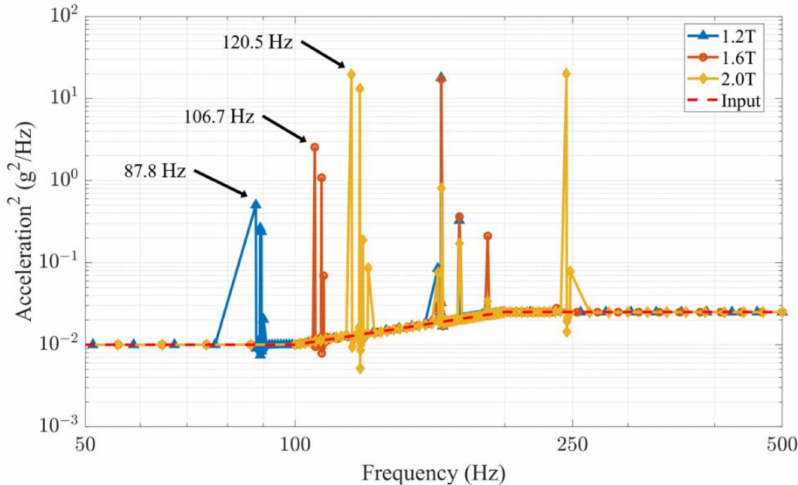
Figure 6. Natural frequencies (f 0 ) along the +Y-axis of the DSP in the axial direction with different DSP thicknesses.